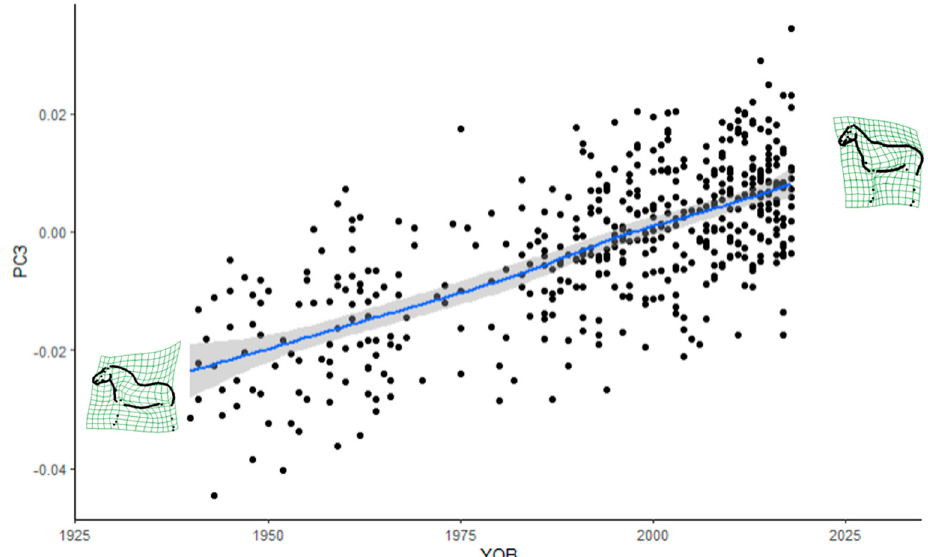
Figure 3. Evolution of the third relative warp score (PC3) in stallions born from 1940 to 2018 (YOB), with the extreme shapes on relative warp grids, with the trend line (in blue, with the confidence interval in light grey) from local polynomial regression fitting.